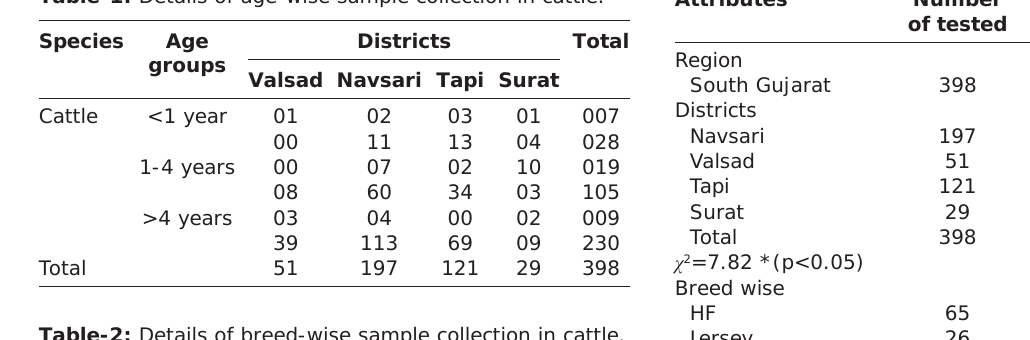
Table-2: Details of breed-wise sample collection in cattle. Species Breeds Districts